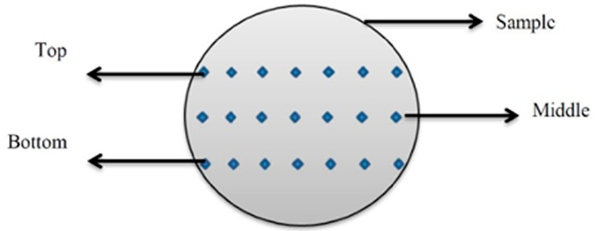
Figure 2. Hardness test points.